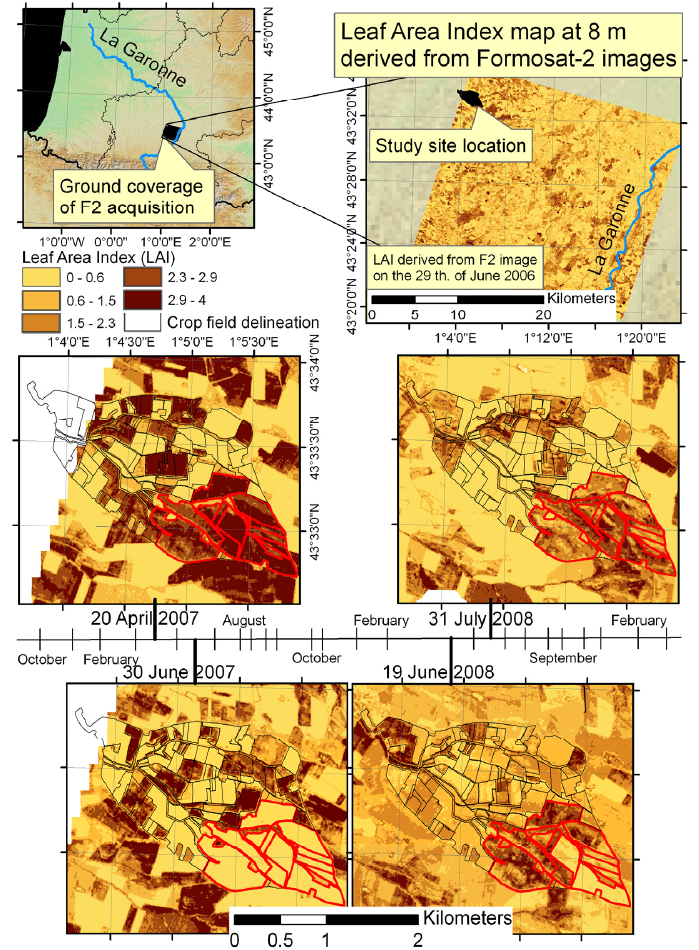
Figure 1. Study site location in southwest France and satellite time series acquisitions details. Four 8 meters resolution Leaf Area Index (LAI) products are shown: high and low LAI correspond to, respectively, well developed wheat and first growing stage sunflower in April; low LAI value for the dry wheat and high LAI for the maturity stage of sunflower in June 2007. The next year (2008), the opposite location of crops are observed, implied by the sunflower and winter wheat crop succession. The area used to test the methodology corresponds to the underlined crop field in red. It corresponds to a homogeneous area in term of crop cover: sunflower in 2006, 2008 and 2010, and winter wheat in 2007 and 2009.